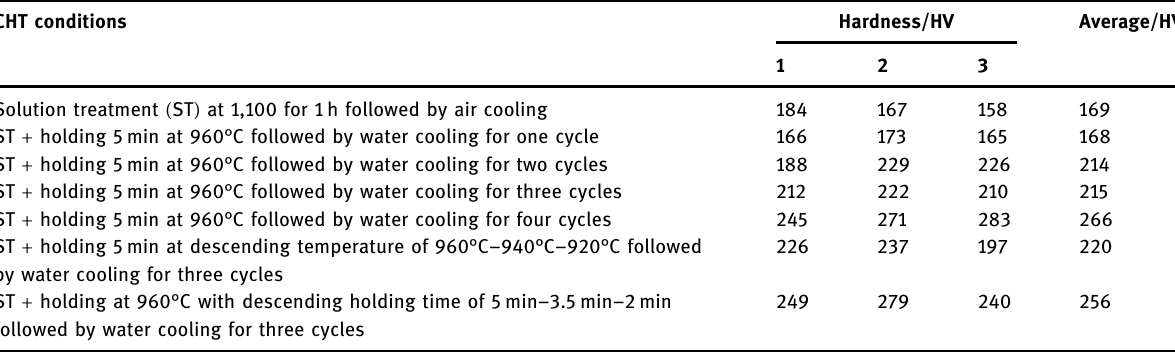
Table 2: Bulk hardness for di ff erent heat treatment conditions CHT conditions